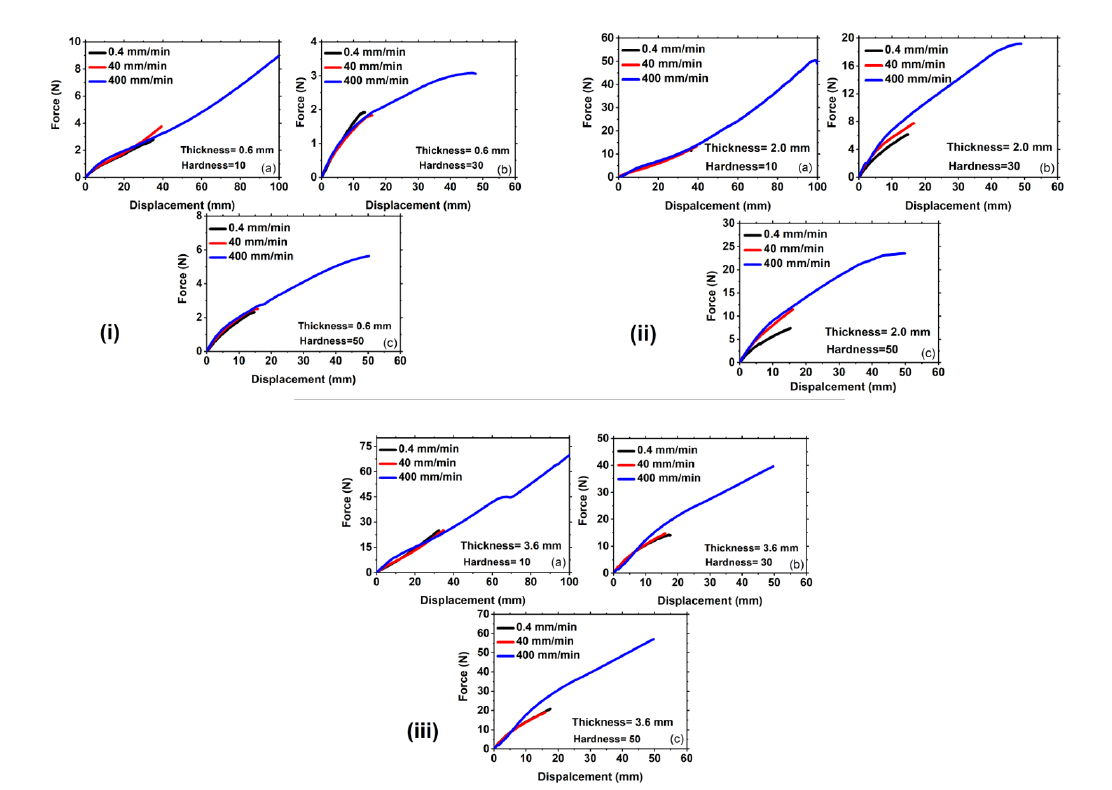
Figure 9. Representation of force versus displacement curves of the specimen under pure shear loading at thicknesses of ( i ) 0.4 mm for different hardness of ( a ) 10; ( b ) 30; and ( c ) 50, respectively, ( ii ) 2.0 mm for different hardness of ( a ) 10; ( b ) 30; and ( c ) 50, respectively, ( iii ) 3.6 mm for different thicknesses of ( a ) 10; ( b ) 30; and ( c ) 50, respectively. Note: the scales of the figures are